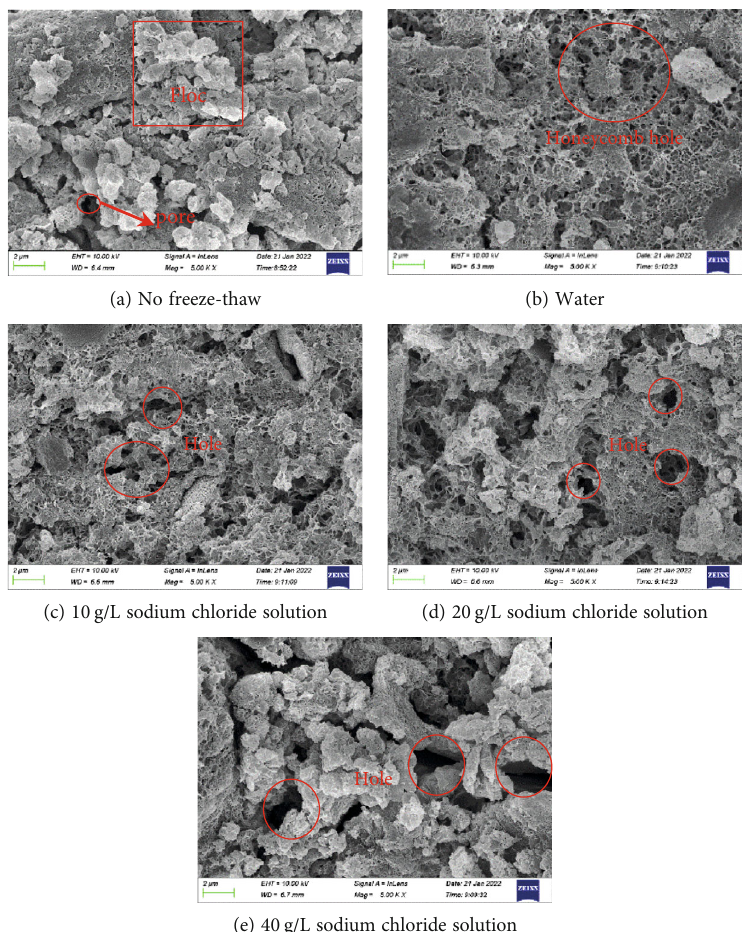
Figure 9: Microstructure of samples with di ff erent treatment